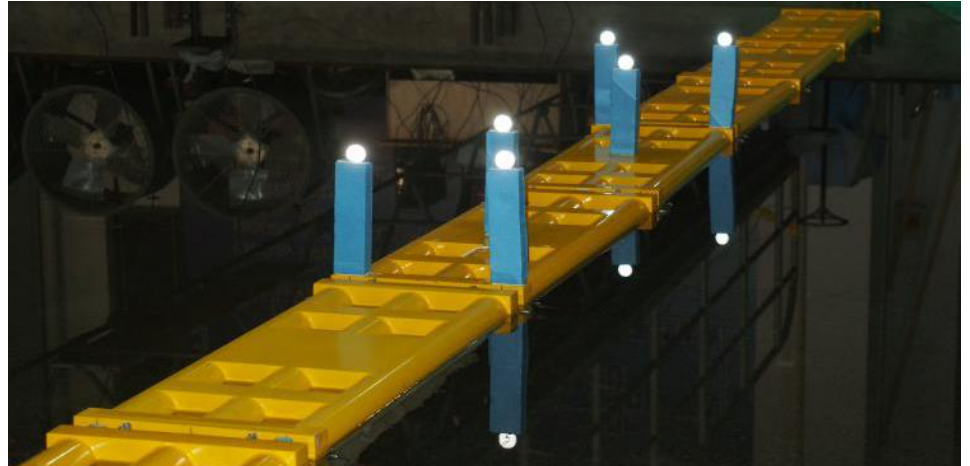
Figure 12. Layout diagram of light sensing points in the experiment.